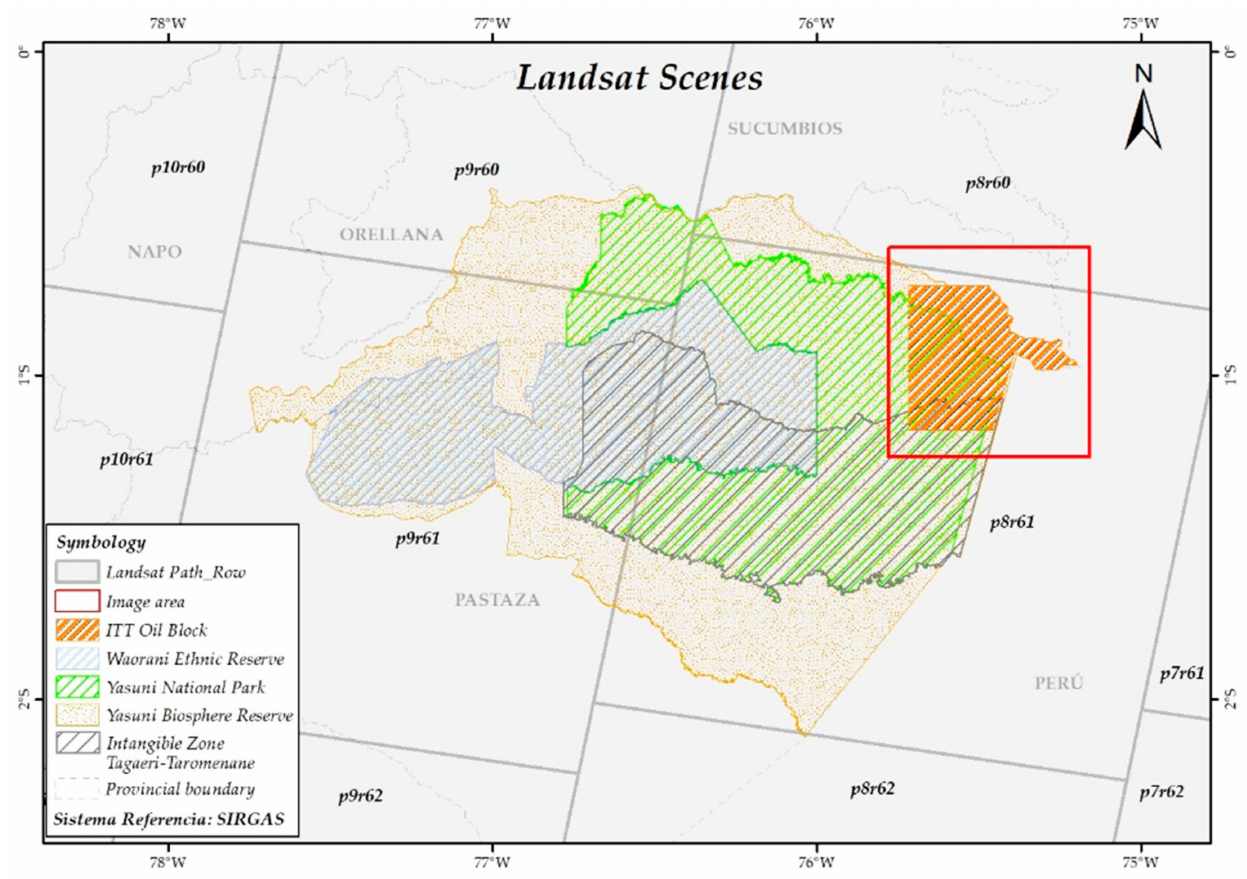
Figure 2. Footprint of satellite images (Landsat 7 and 8) in the ITT Oil Block of the Ecuadorian Amazon